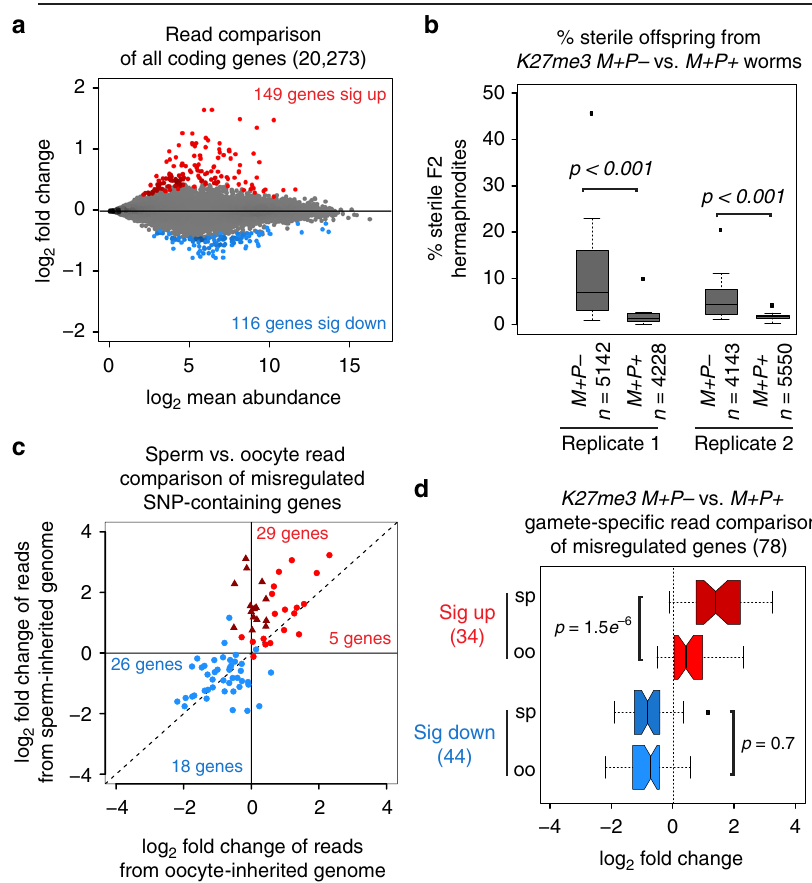
Fig. 2 Inheritance of sperm chromosomes lacking H3K27me3 alters germline transcription and function in offspring. a MA plot comparing germline transcripts (RNA-seq reads) from K27me3 M + P − hermaphrodites to genetically identical K27me3 M + P + hermaphrodites. Genes that are signi fi cantly upregulated or downregulated ( p < 0.1) are highlighted in red and blue, respectively. b Boxplots showing percent sterility of the F2-generation hermaphrodites from K27me3 M + P − and K27me3 M + P + F1 worms for each of 2 replicates. n = the number of F2 worms scored. Each box extends from the 25th to the 75th percentile, with the median indicated by the horizontal line; whiskers extend to the most extreme data point which is no more than 1.5 times the interquartile range from the box; individual data points outside of these boundaries are shown as fi led boxes. p -values were calculated using a Wilcoxon rank sum test. c Scatter plot comparing sperm-speci fi c and oocyte-speci fi c log 2 fold changes of SNP-containing reads from signi fi cantly upregulated genes (in red) and downregulated genes (in blue). Genes upregulated in cis (>1.5-fold increase in reads from the sperm allele; <1.5-fold increase from the oocyte allele) are plotted as dark red triangles. The numbers of misregulated genes above and below the diagonal line are indicated. d Boxplots showing sperm-speci fi c (sp) and oocyte-speci fi c (oo) log 2 fold changes of signi fi cantly upregulated genes (34 genes sig up) and signi fi cantly downregulated genes (44 sig down). Downregulated genes (blue) are similarly downregulated from sperm and oocyte alleles, while upregulated genes (red) are signi fi cantly more upregulated from sperm alleles than oocyte alleles (i.e., pairwise comparisons of transcript reads from sperm vs. oocyte alleles indicate that sperm allele reads are signi fi cantly more numerous than oocyte allele reads for upregulated genes but not for downregulated genes). Each box extends from the 25th to the 75th percentile, with the median indicated by the horizontal line; whiskers extend to the most extreme data point which is no more than 1.5 times the interquartile range from the box; the individual data point outside of these boundaries is shown as a fi lled box. The waist indicates the 95% con fi dence interval for the medians. p -values were generated using the paired student ’ s t